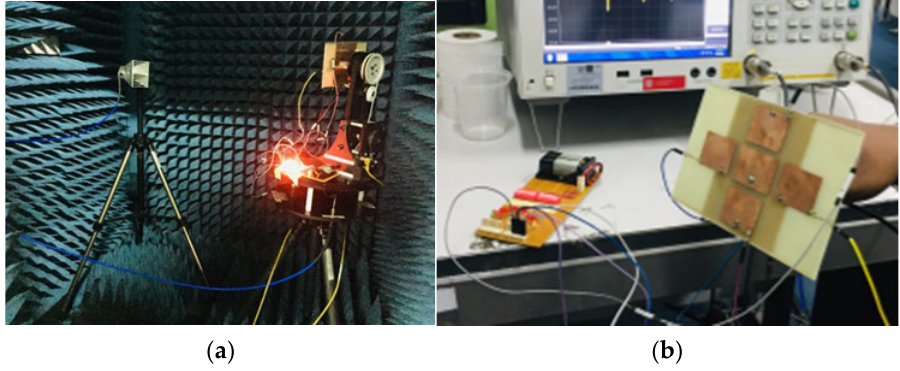
Figure 6. Measurement setup for ( a ) reflection coefficient and ( b ) radiation pattern.